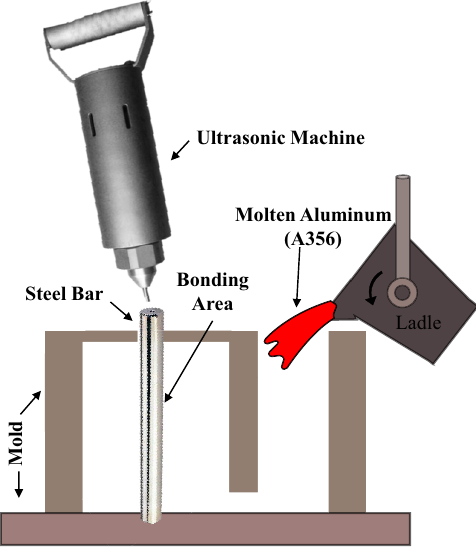
Figure 1: Fabrication process of carbon steel and A356 aluminum alloy bimetal castings with